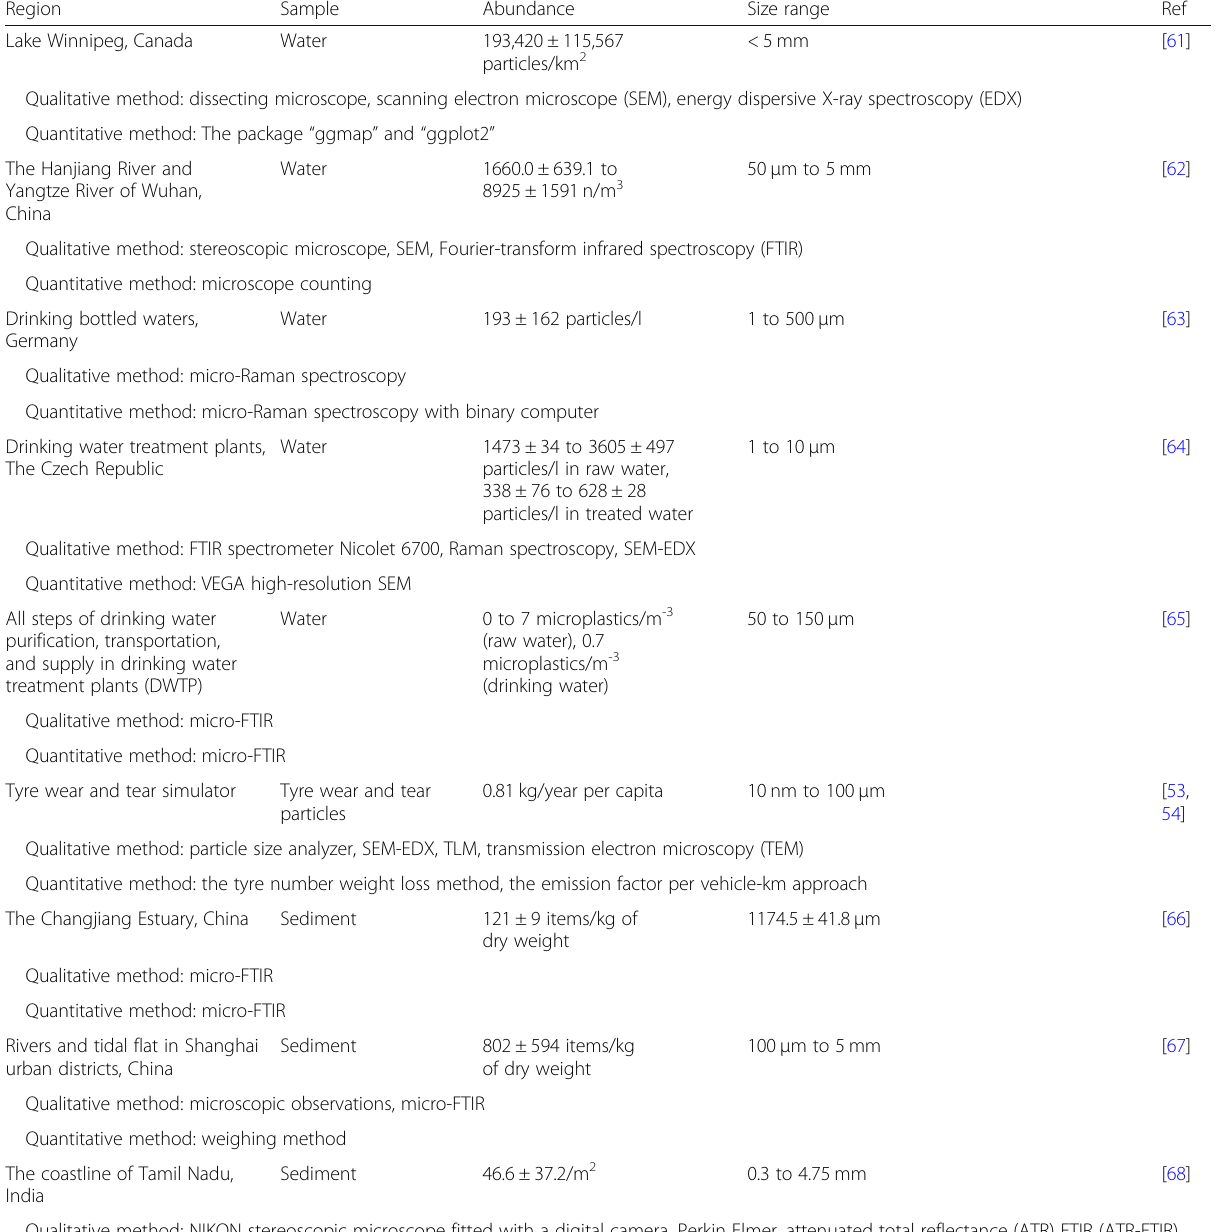
Table 1 Summary of published studies providing data on abundance, size range, and qualitative and quantitative methods of micro- and nanoplastics (MNPs) from 2016 to 2020 Region Sample